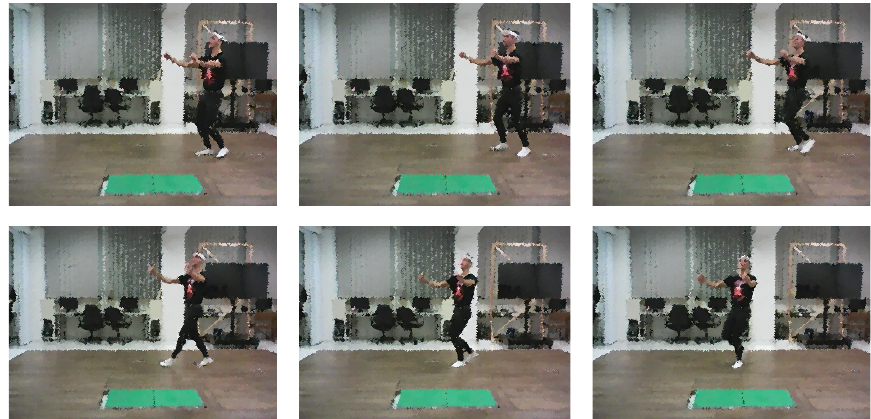
Figure 9. Illustration of Syrtos dance (2 beats, circular